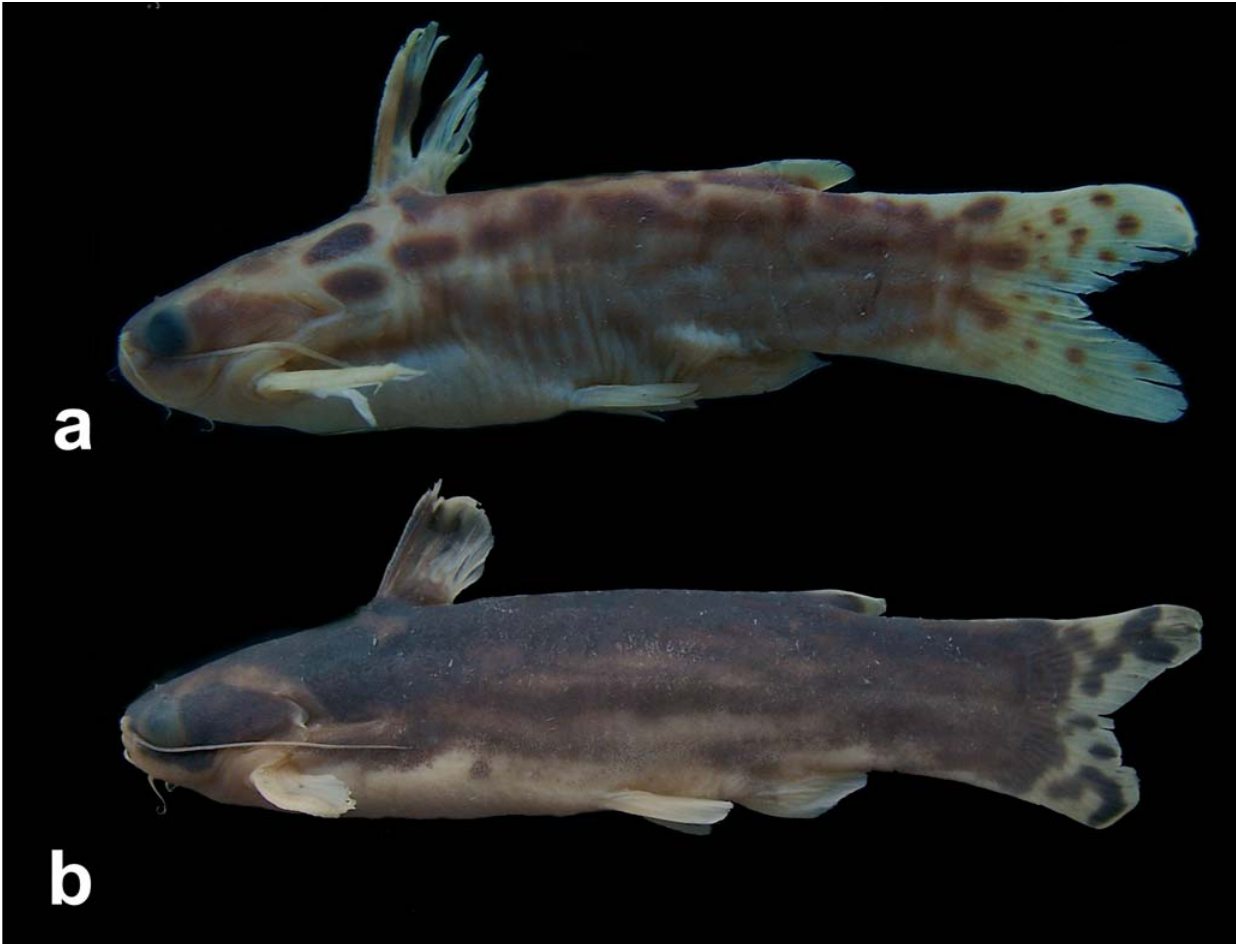
Fig. 13. Tatia brunnea . (a) AMNH 58390, paratype, male, 54.6 mm SL, Kamaloe Stream, Suriname. (b) MZUSP 81250, female, 52.4 mm SL, Tiquié river, Amazonas State,